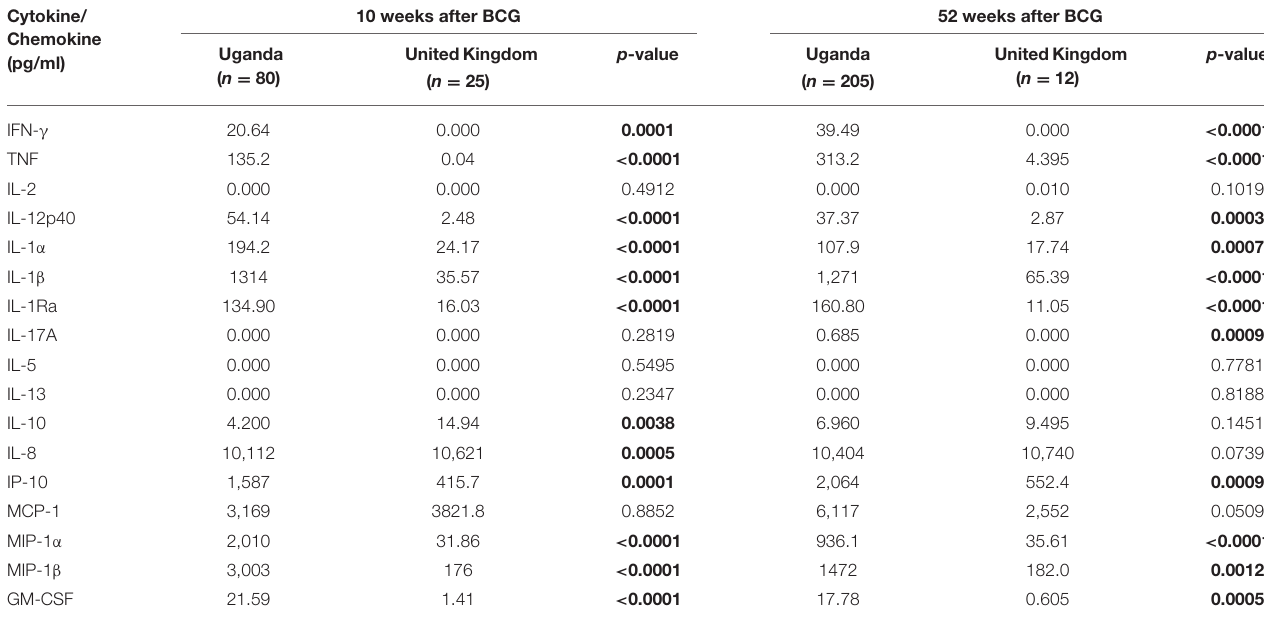
TABLE 3 | Median responses to ESAT6/CFP10 in infants from Uganda and United Kingdom at 10 and 52 weeks following BCG immunization. Cytokine/ Chemokine